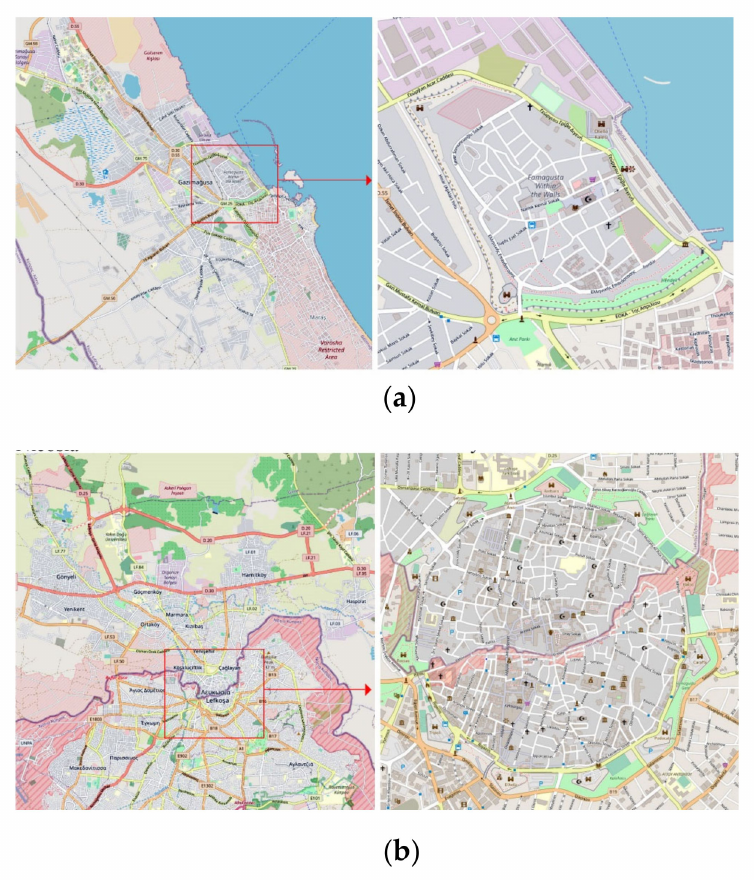
Figure 3. The city and walled city of Famagusta ( a ); The city and walled city of Nicosia ( b